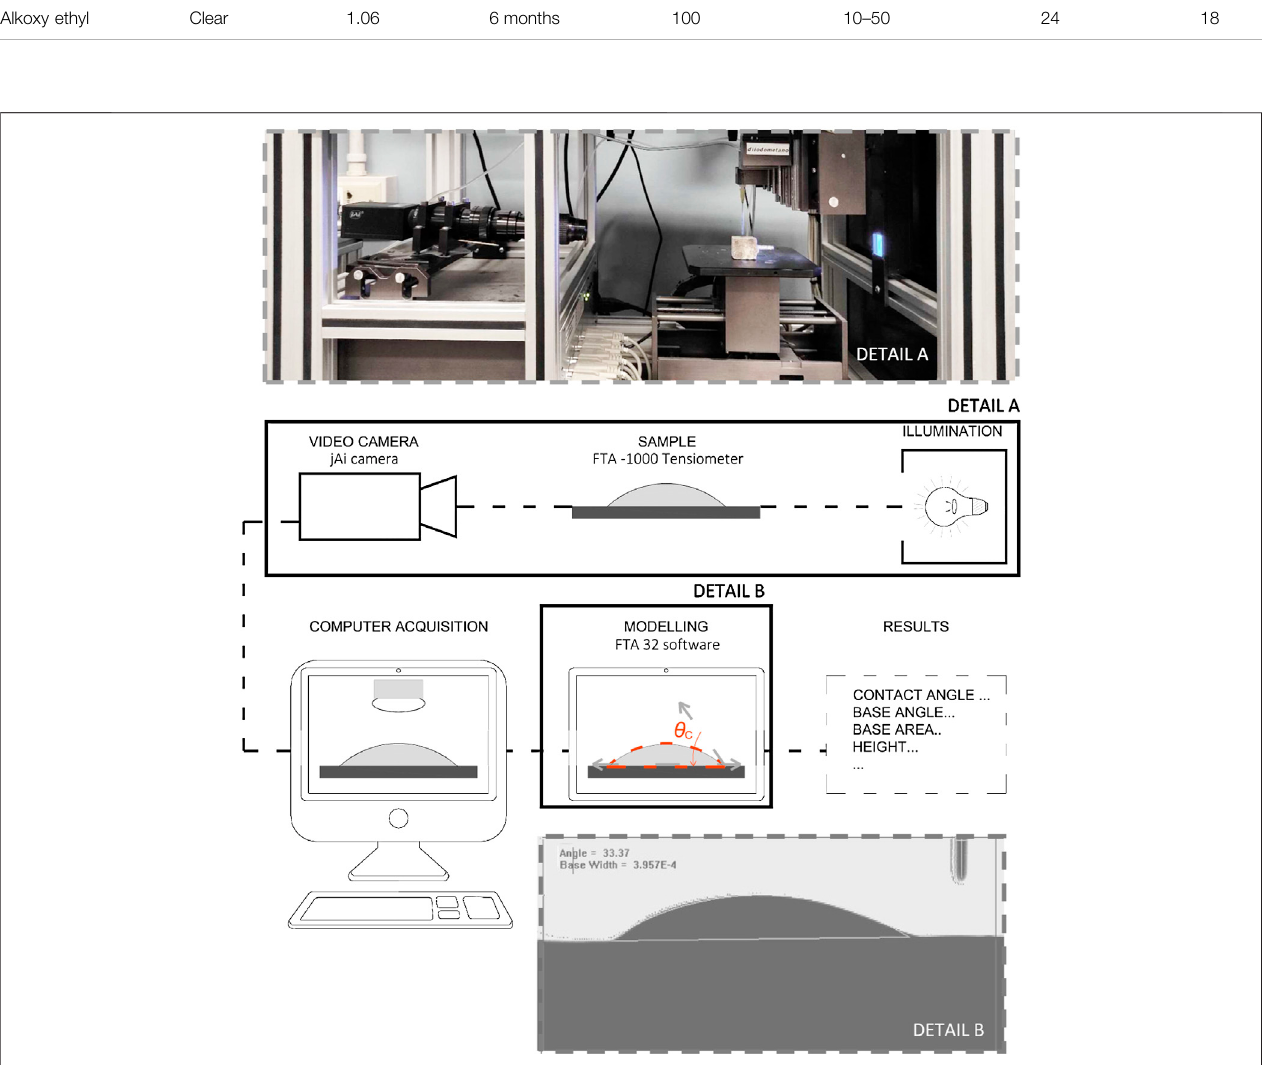
FIGURE 4 | Sessile drop measurement